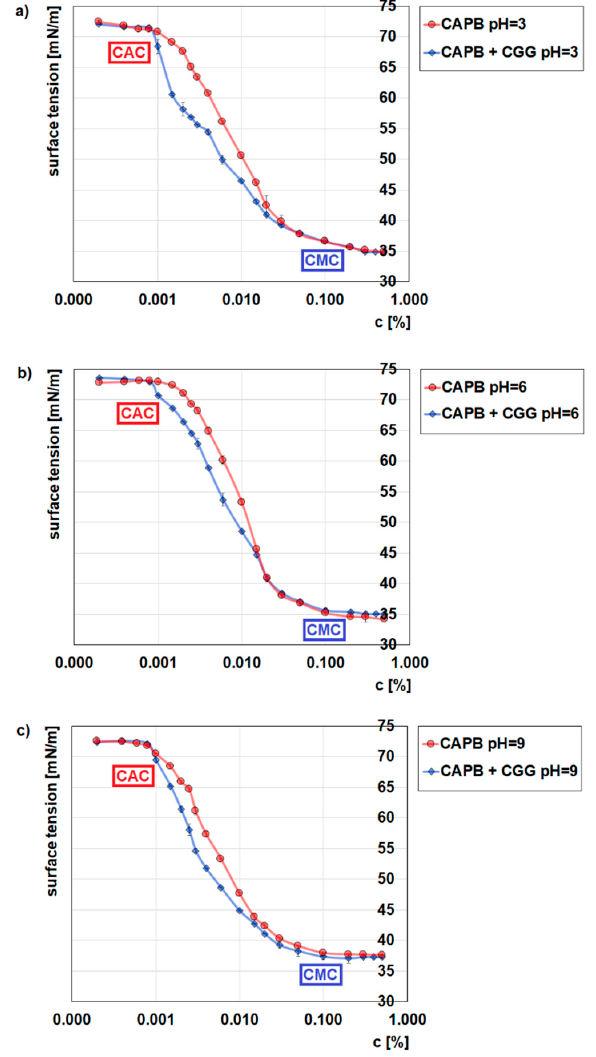
Figure 5. Influence of CGG (200 ppm) on the surface tension of CAPB at pH = 3 ( a ), pH = 6 ( b ), and pH = 9 ( c ).